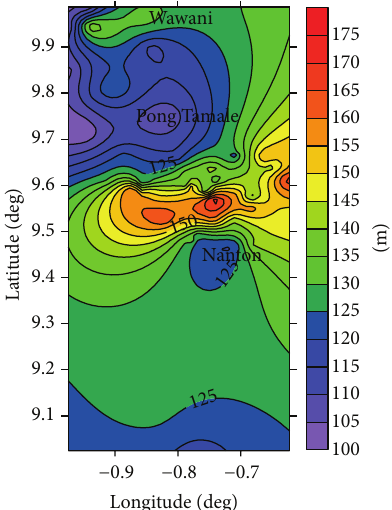
Figure 7: Local topographical map of the study